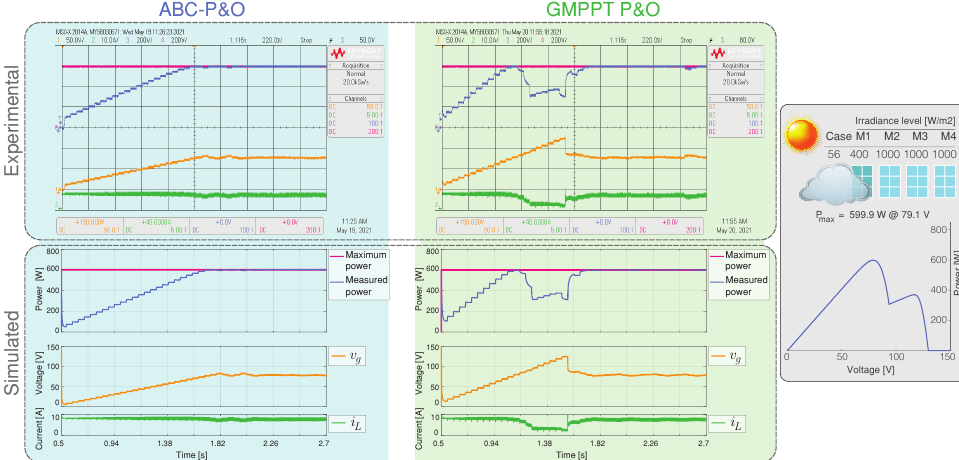
Figure 7. Simulated and experimental dynamic behavior of the MPPT algorithms for Scenario 1 and an output voltage V o = 160 V. The proposed MPPT algorithm (left) is compared with GMPPT P&O (right). CH1: v g (50 V/div), CH2: i L (10 A/div), CH3: maximum power (200 W/div), CH4: measured power (200 W/div), and a time base of 220 ms.